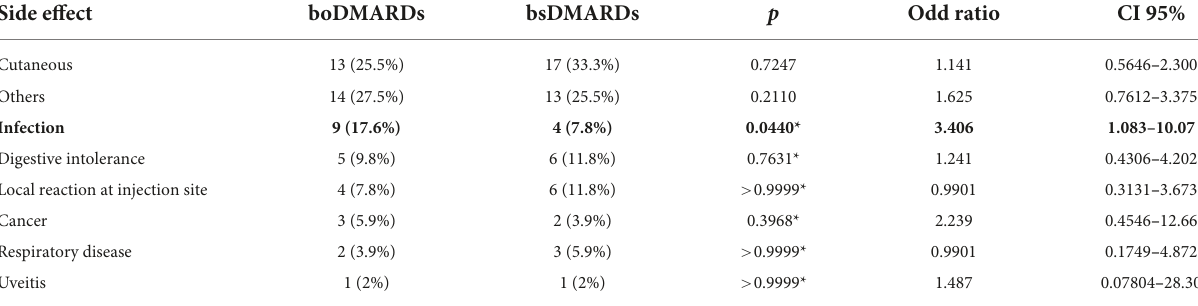
TABLE 6 Details of side effects